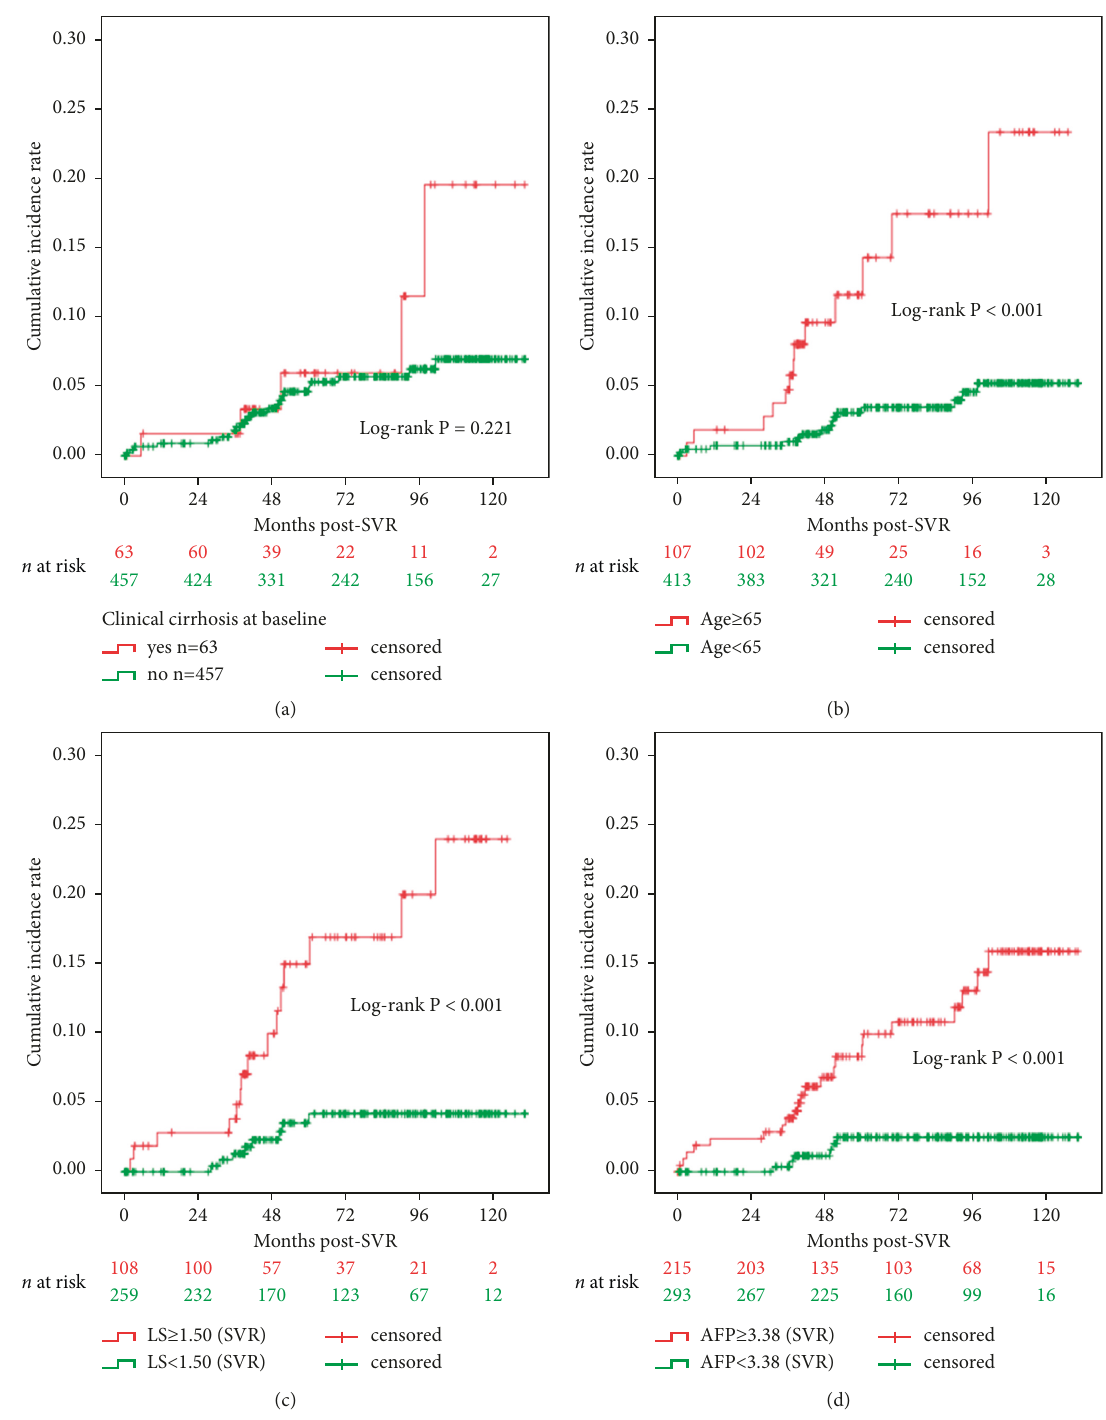
Figure 2: Kaplan–Meier survival analysis to predict LREs since the baseline of SVR visit. (a) LREs ( n (TW0), (b) LREs ( n 28), stratified by age (year) (TW0), (c) LREs ( n (cid:31) AFP (ng/mL) (SVR). Participants with missing data of LS or AFP were excluded from the analysis. AFP, α -fetoprotein; LRE, liver-related event; LS, liver stiffness; SVR, sustained virologic response (visit); TW0, treatment